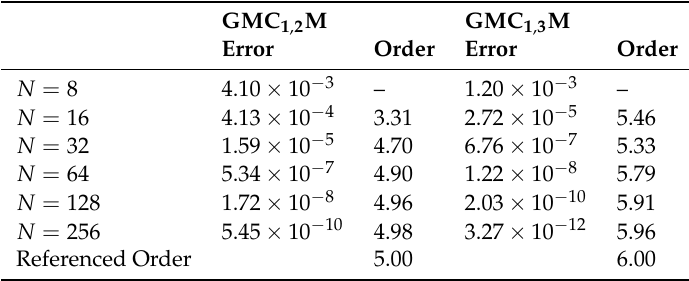
M for Example 1. 1 , k 2